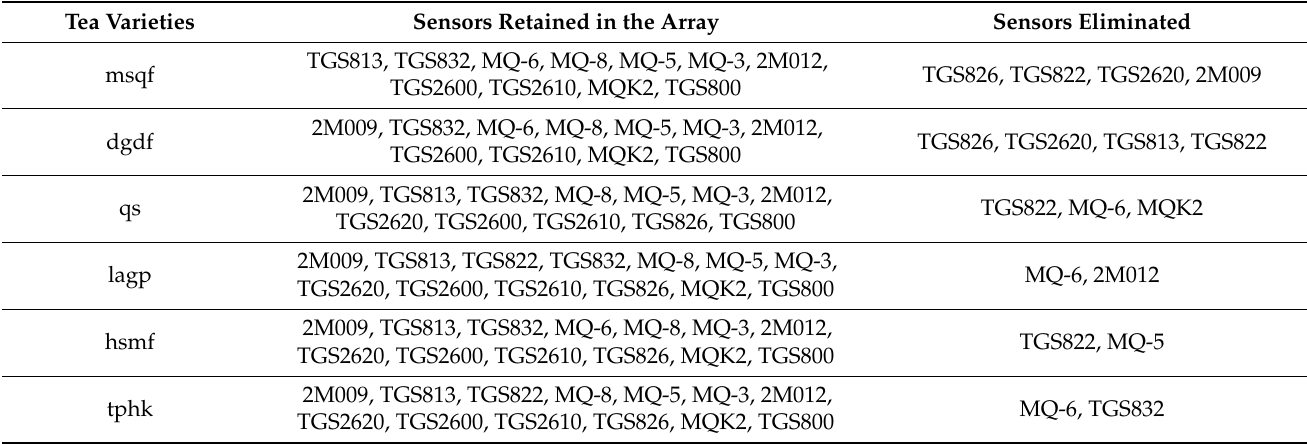
Table 5. Optimized sensor array LG for general green